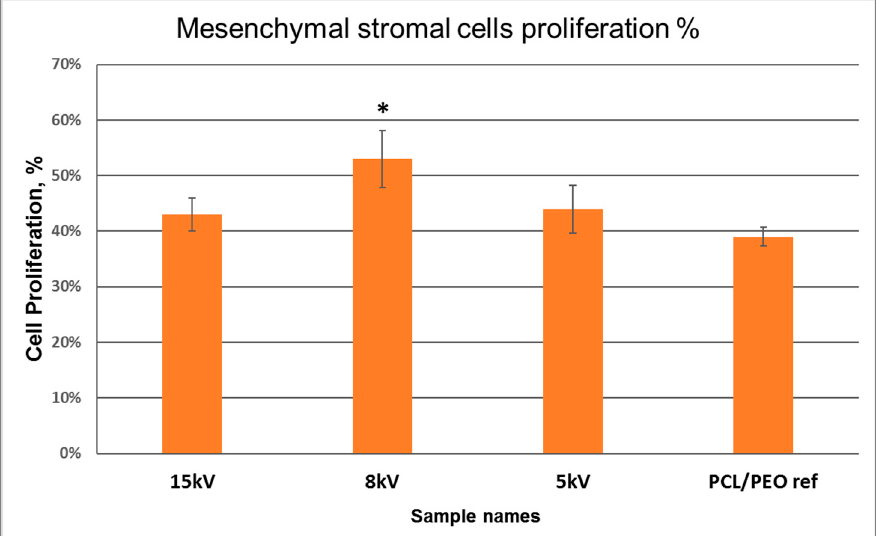
Figure 5. The hMSC proliferation results in PCL/PEO-Ti0.5-Ag-15 kV (denoted 15 kV), PCL/PEO- Ti0.3-Ag-8 kV (denoted 8 kV) and PCL/PEO-Ti0.3-Ag-5 kV (denoted 5 kV) and PCL/PEO-ref. Data presented as mean ± std. * Statistical significance is p < 0.05.